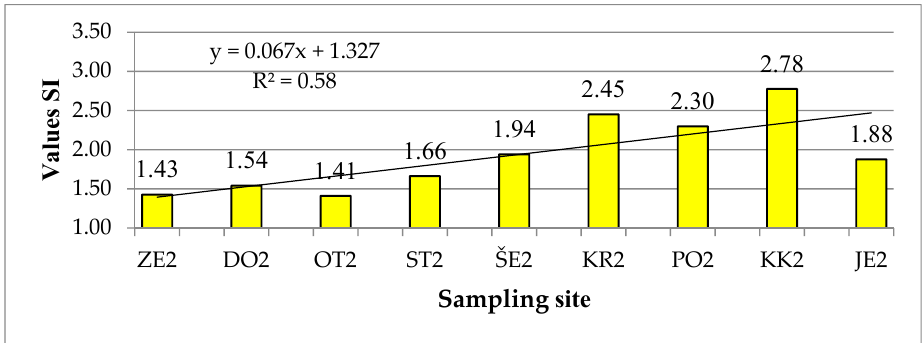
Figure 4. Saprobic index values for all winter samples (Sampling sites are defined in Figure 1). Figure 5. Saprobic index values for all summer samples (Sampling sites are defined in Figure 1).